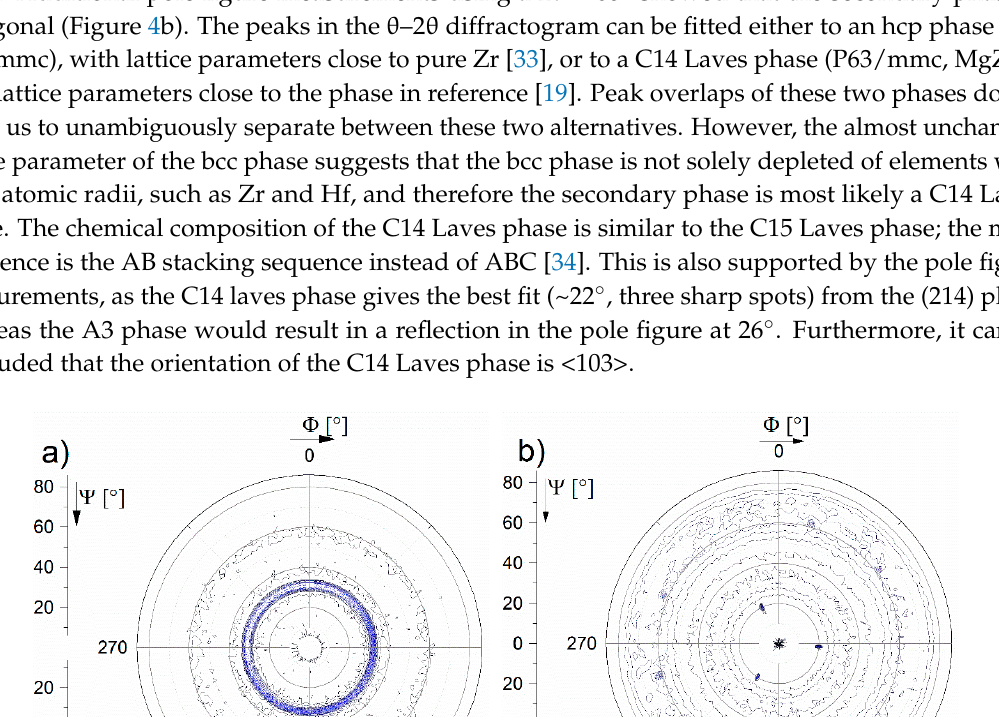
Table 1. Deposition parameters phase composition, hardness H, and Young’s modulus E . T sub (°C) Phases H (GPa)